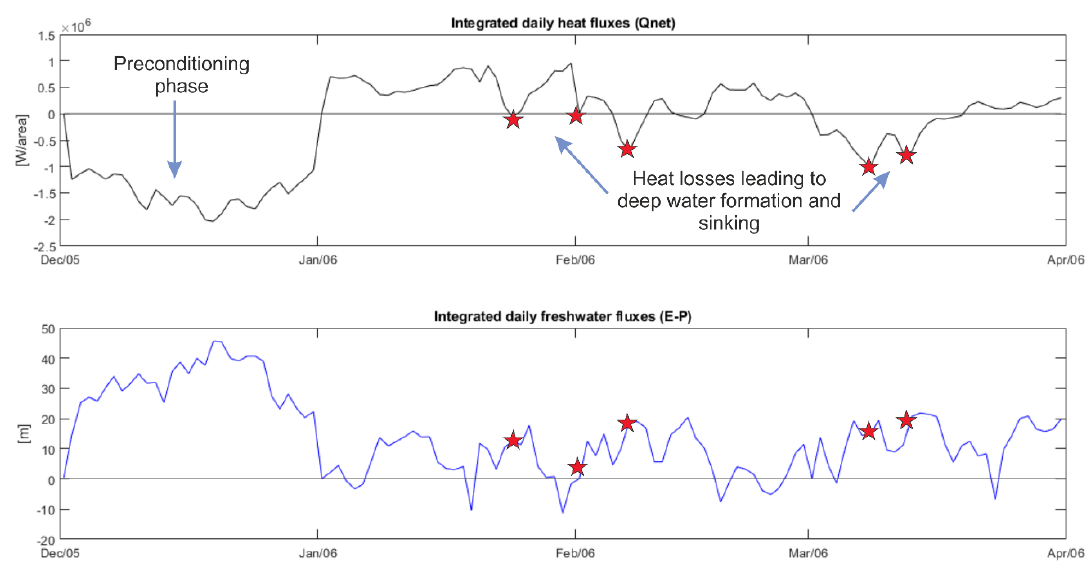
Figure 8. Upper panel: Time series of integrated daily surface heat fluxes from December 2005 to April 2006 for the center of Rhodes Gyre. The heat losses by the end of January and mid-February induced deep convection and formation of Levantine deep water (LDW) while the heat losses in March induced mixing and formation of LDW and ‘lower range’ LIW (see also Figure 6). Lower panel: Time series of integrated daily freshwater fluxes for the same time period as the above panel. The freshwater fluxes in December show a strong evaporation which led to increased surface salinity as shown by the Argo float data (Figure